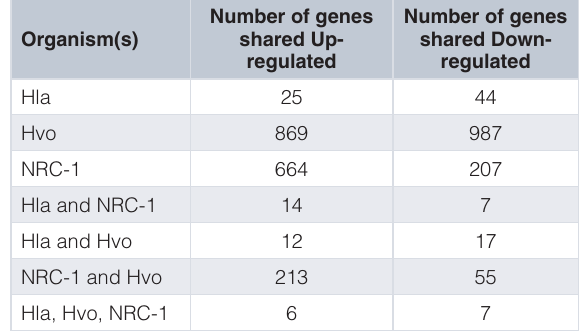
Table 2. Transcripts regulated under growth in acidic conditions.